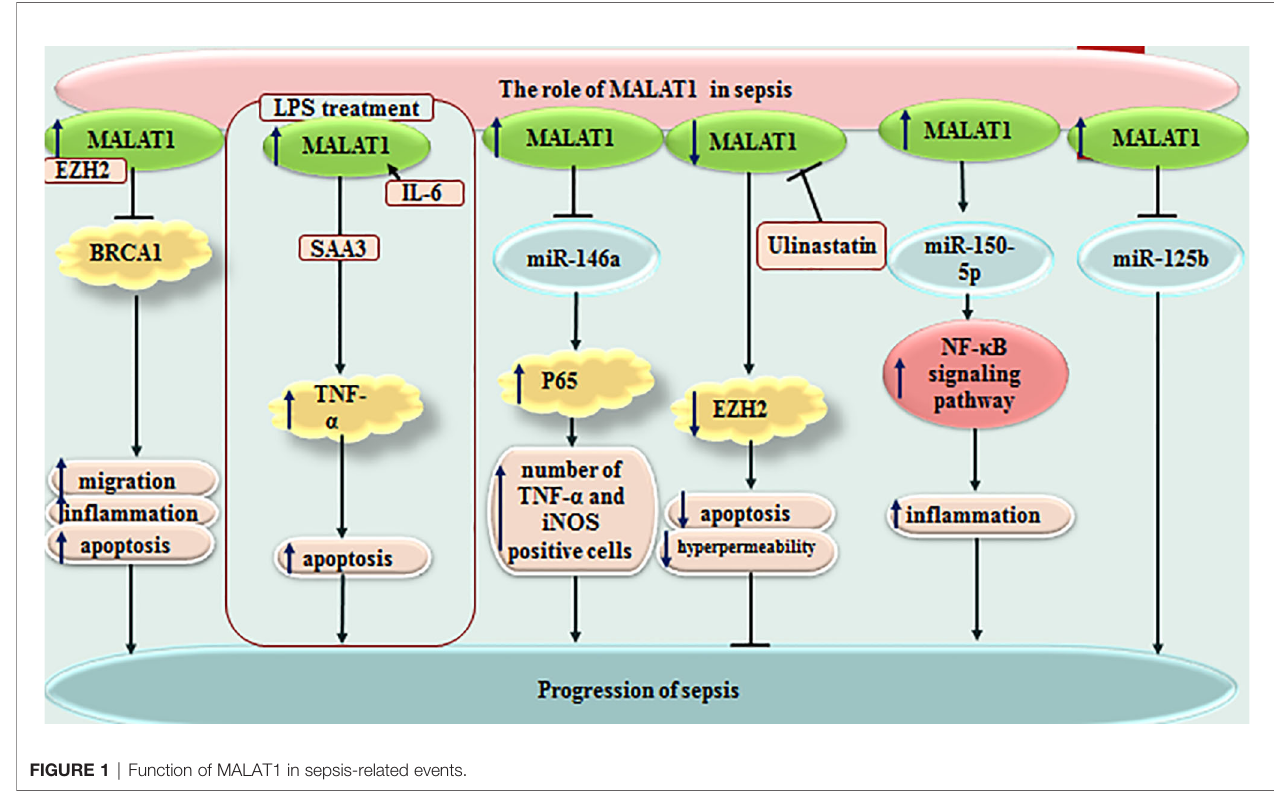
FIGURE 1 | Function of MALAT1 in sepsis-related